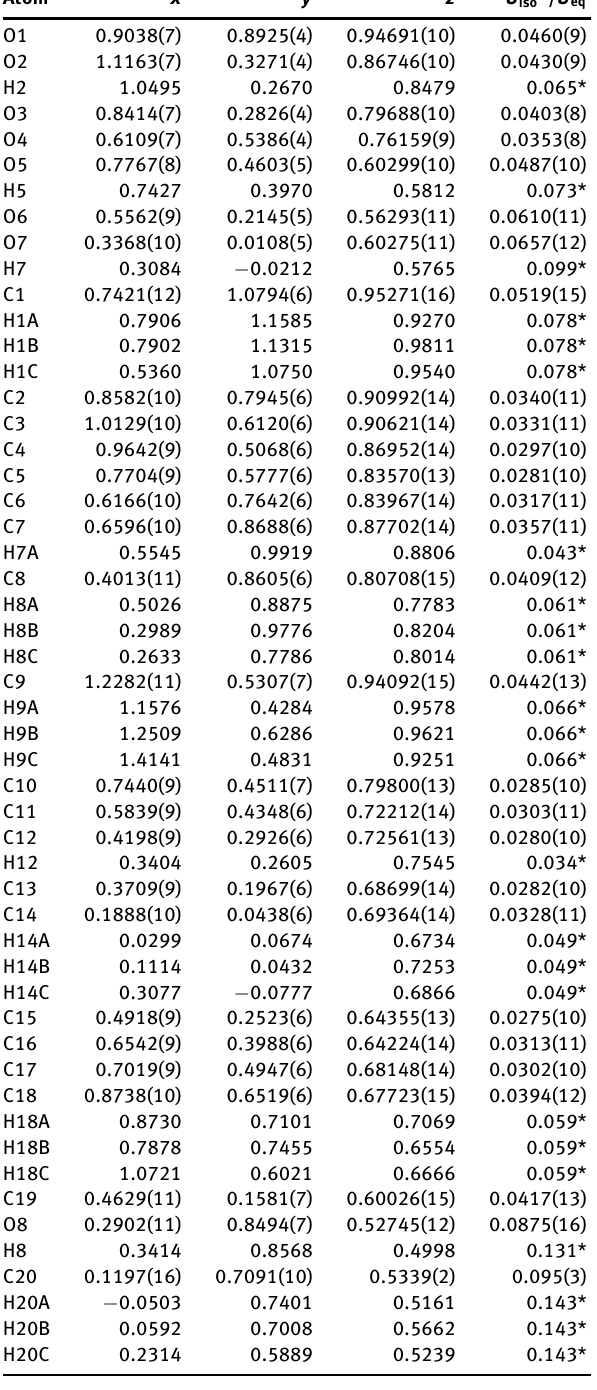
Table 2: Fractional atomic coordinates and isotropic or equivalent isotropic displacement parameters (Å 2 ).